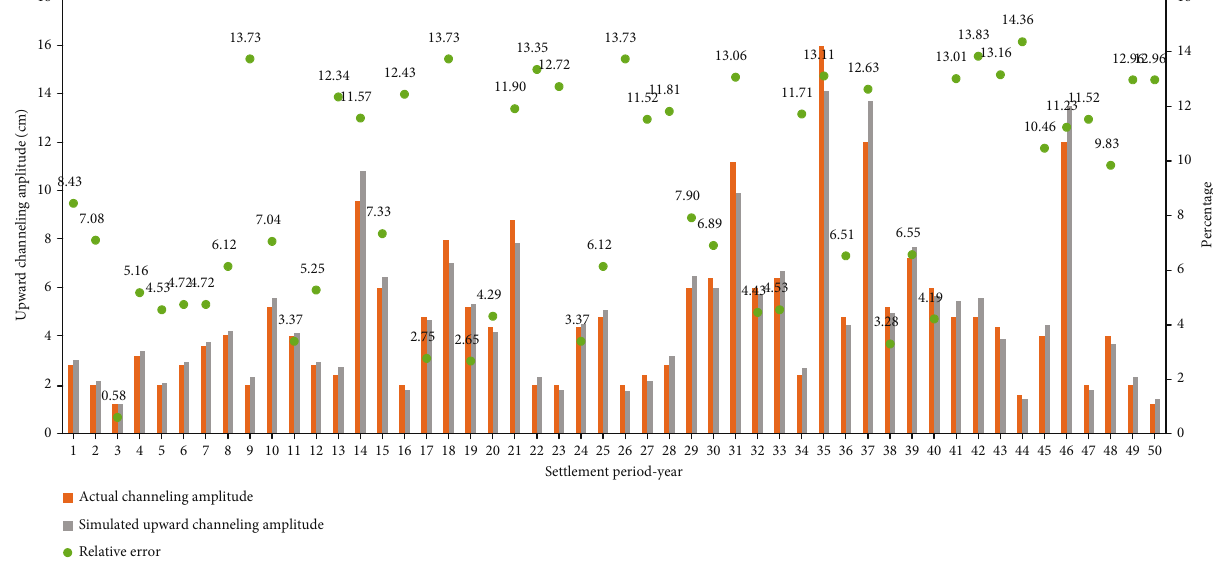
Figure 10: Curve relationship of surface settlement in LN5-6 well over time.